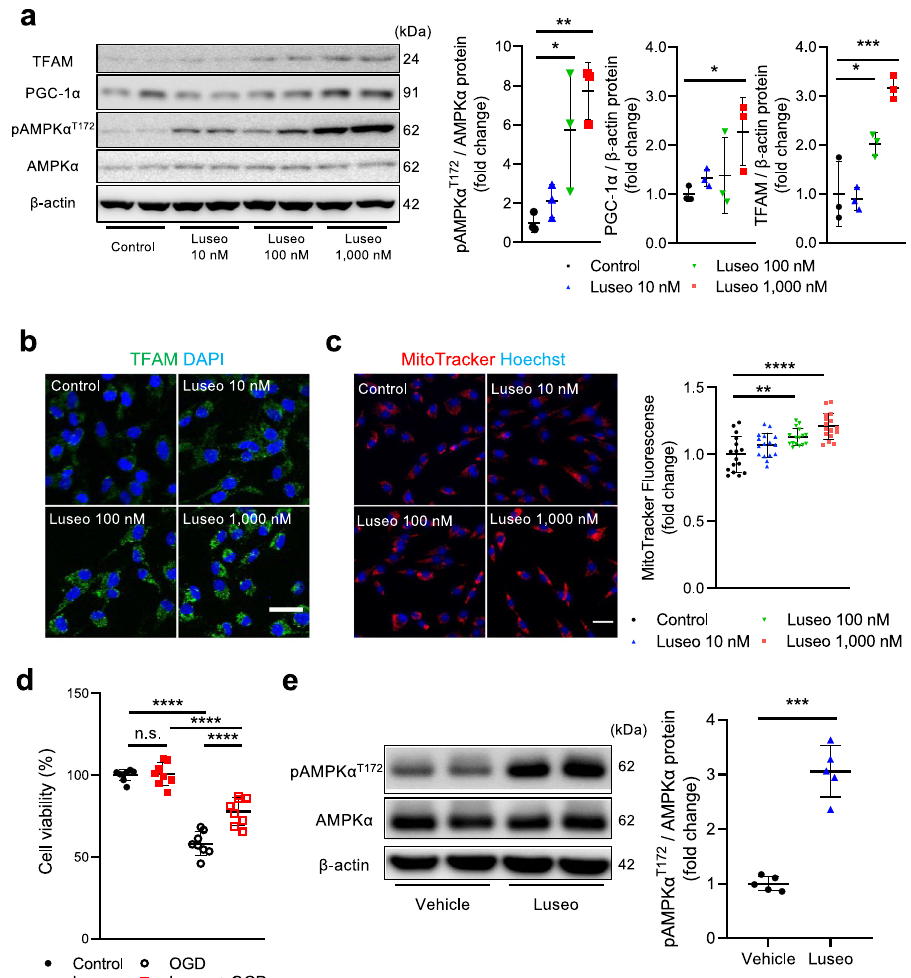
Fig. 5 Luseogli fl ozin activates mitochondrial biogenesis by activating AMPK α and PGC-1 α in brain pericytes. a – c Cultured brain pericytes were treated with 0, 10, 100, or 1000 nmol/L luseogli fl ozin for 24 h. a Representative immunoblotting for pAMPK α T172 , AMPK α , PGC-1 α , TFAM, and β -actin is shown, and their levels were quanti fi ed using densitometry. Protein expression level was normalized to that of AMPK α or β -actin ( n = 3). b Representative images of immuno fl uorescence for TFAM (green) and DAPI (blue) in pericytes treated with luseogli fl ozin. c Representative live-cell imaging of cells labeled with MitoTracker (red) and Hoechst (blue) in pericytes treated with luseogli fl ozin and the quanti fi cation of the MitoTracker fl uorescence intensity measured using a microplate reader ( n = 16). d Cultured pericytes were treated with or without 1,000 nmol/L luseogli fl ozin for 24 h, followed by 16-h oxygen-glucose deprivation. Cell viability was evaluated using LDH assay ( n = 8). e Luseogli fl ozin, mixed in food at a concentration of 0.0001%, was administered orally to C57BL/6JJcl mice for 2 weeks. Representative immunoblotting for pAMPK α T172 , AMPK α , and β -actin of the mice brain cortex is shown. Activated pAMPK α T172 levels were quanti fi ed using densitometry and normalized to that of AMPK α ( n = 5 mice). Data are presented as dot-plots of individual experiments and mean values ± standard deviation. n.s. (not signi fi cant) P > 0.05, * P < 0.05, ** P < 0.01, *** P < 0.001, **** P < 0.0001 by One-way ANOVA followed by Bonferroni ’ s post hoc test ( a , c , d ) or by unpaired t -test ( e ). Luseo luseogli fl ozin, TFAM mitochondrial transcription factor A, OGD oxygen- glucose